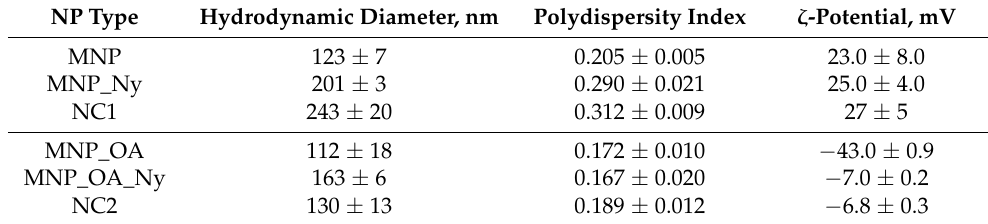
Table 2. DLS data for MNP_Ny, MNP_OA_Ny, NC1, and